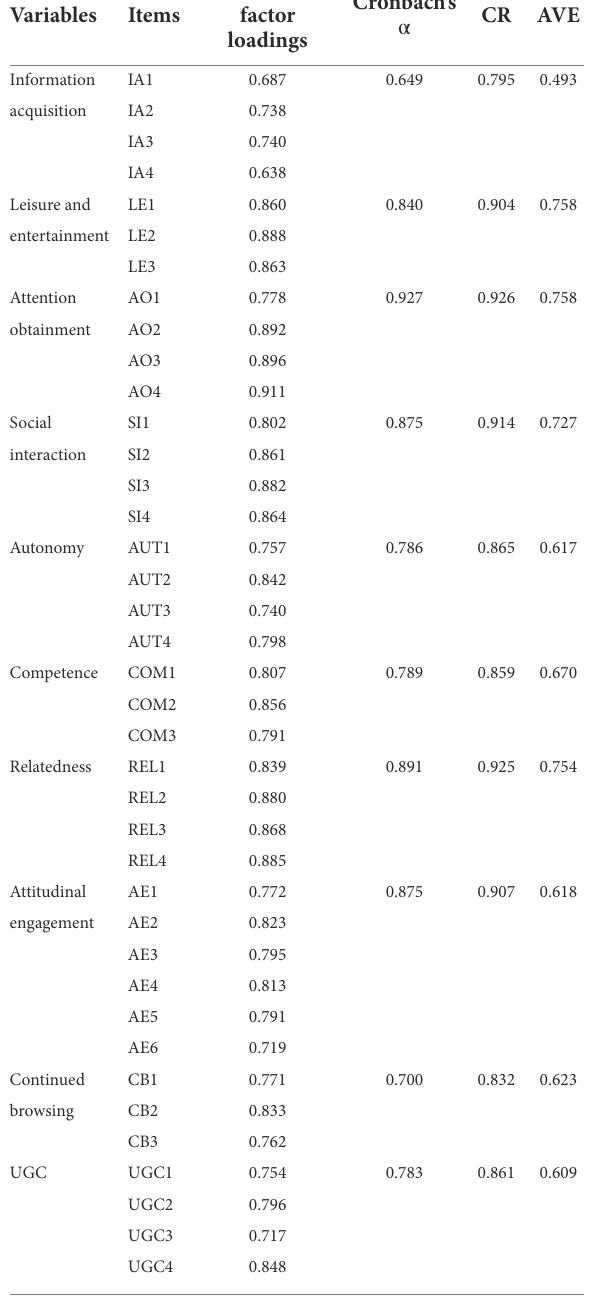
TABLE 2 Results of reliability and validity